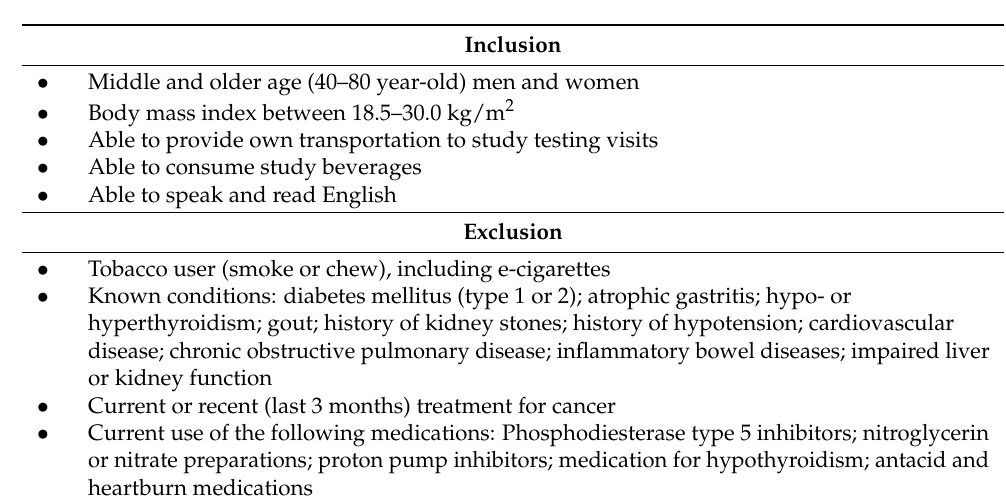
Table 1. Inclusion and Exclusion